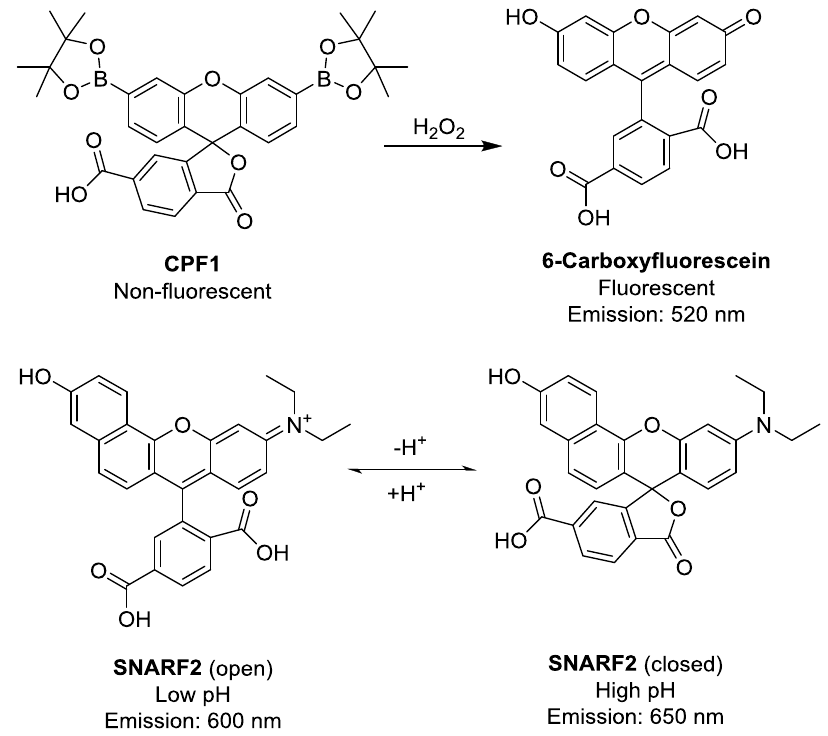
Figure 1. Chemical structures of fluorescent probes used in this study. Carboxyperoxyfluor-1 (CPF1) reacts with H 2 O 2 to form the fluorescent 6-carboxyfluorescein. Seminaphthorhodofluor-2 (SNARF2) is found in the protonated (open) form and lactone (closed) at low and high pH respectively.